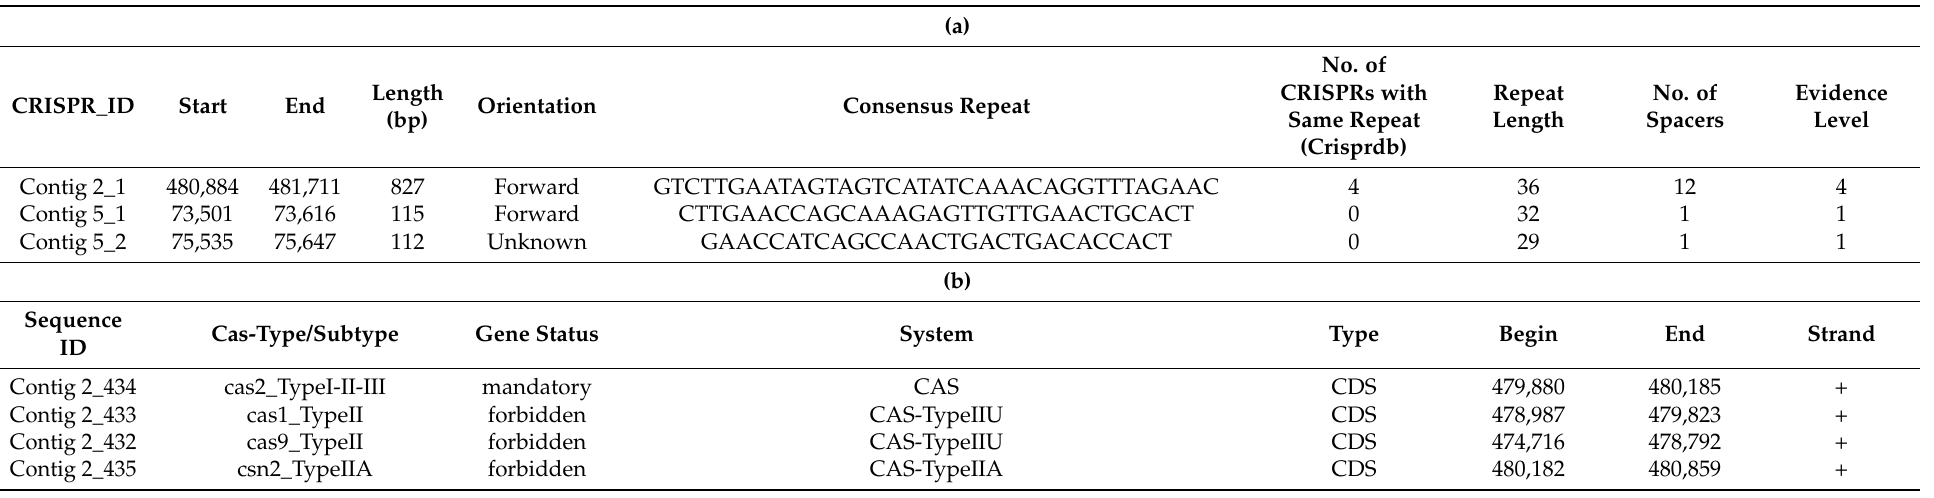
Table 5. Crispr array system (a) and Cas type detection (b) within Lactiplantibacillus plantarum DJF10 genome using CRISPRFinder tool.